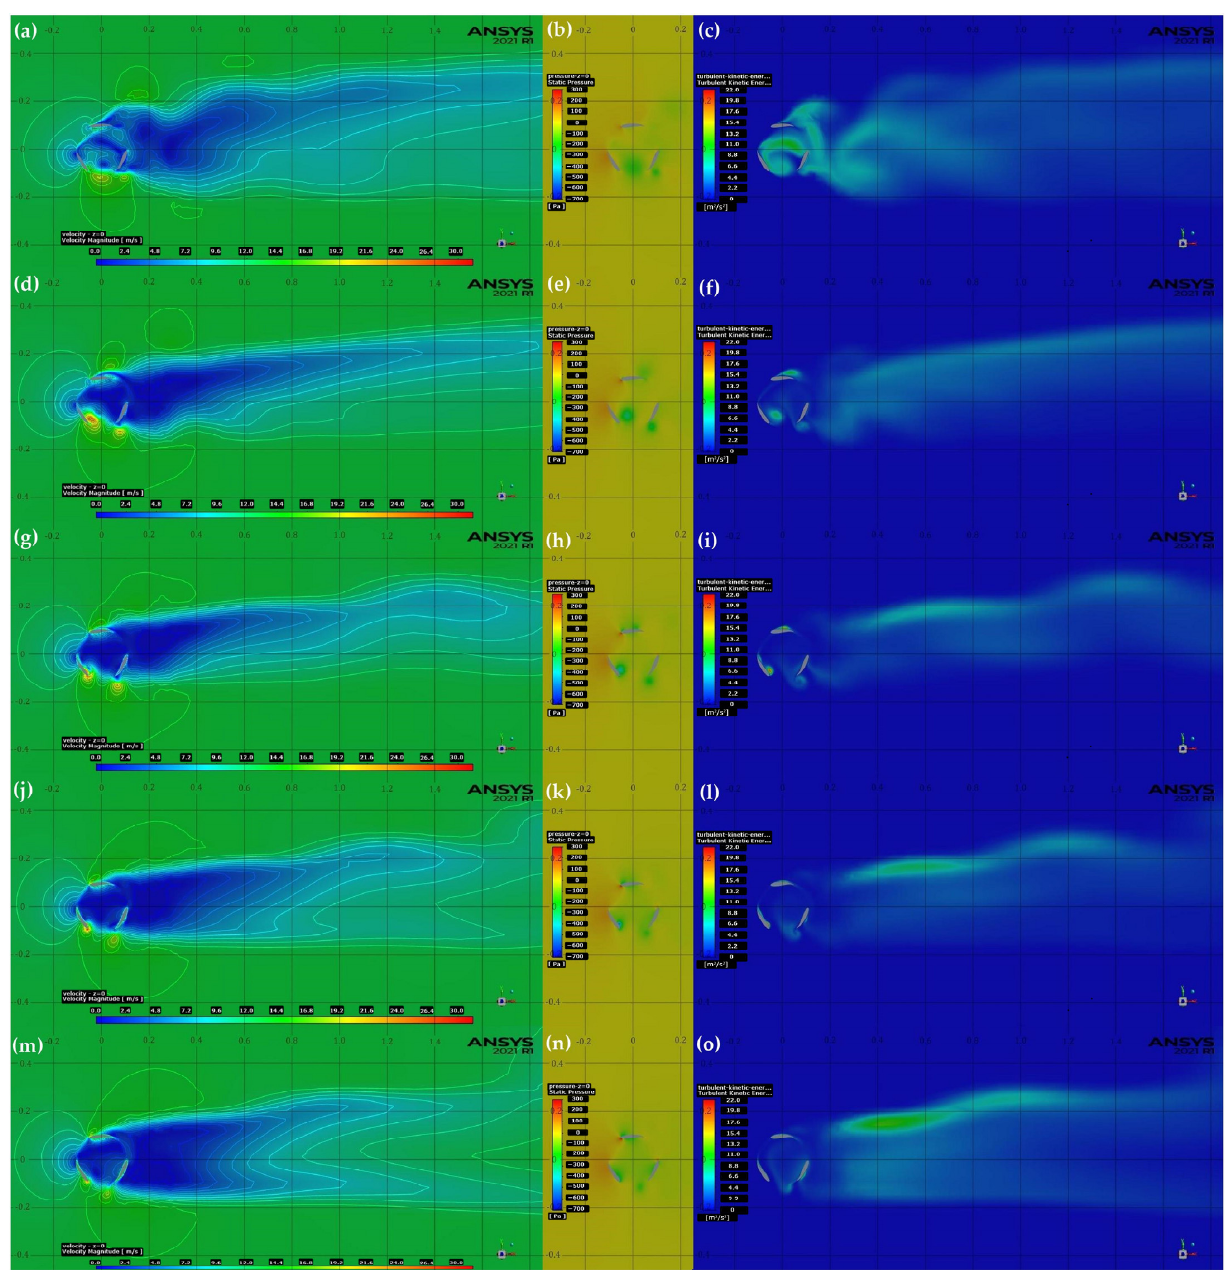
Figure 10. Contours for 14 m/s wind speed of: ( a ) Velocity at TSR of 0.3; ( b ) Pressure at TSR of 0.3; ( c ) Turbulent kinetic energy (TKE) at TSR of 0.3; ( d ) Velocity at TSR of 0.5; ( e ) Pressure at TSR of 0.5; ( f ) TKE at TSR of 0.5; ( g ) Velocity at TSR of 0.7; ( h ) Pressure at TSR of 0.7; ( i ) TKE at TSR of 0.7; ( j ) Velocity at TSR of 0.9; ( k ) Pressure at TSR of 0.9; ( l ) TKE at TSR of 0.9; ( m ) Velocity at TSR of 1.1; ( n ) Pressure at TSR of 1.1; ( o ) TKE at TSR of 1.1.